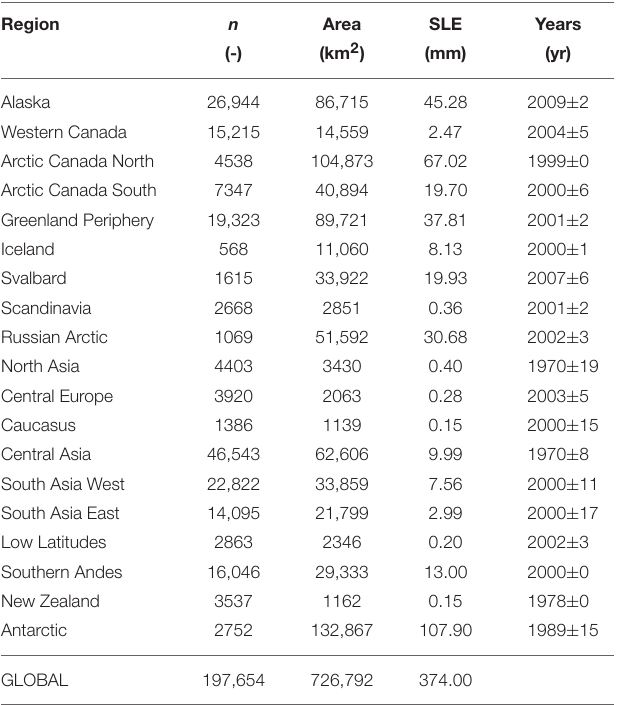
TABLE 1 | Number of glaciers n and glacier area according to the Randolph Glacier Inventory (RGIv4.0) (Pfeffer et al., 2014). Region